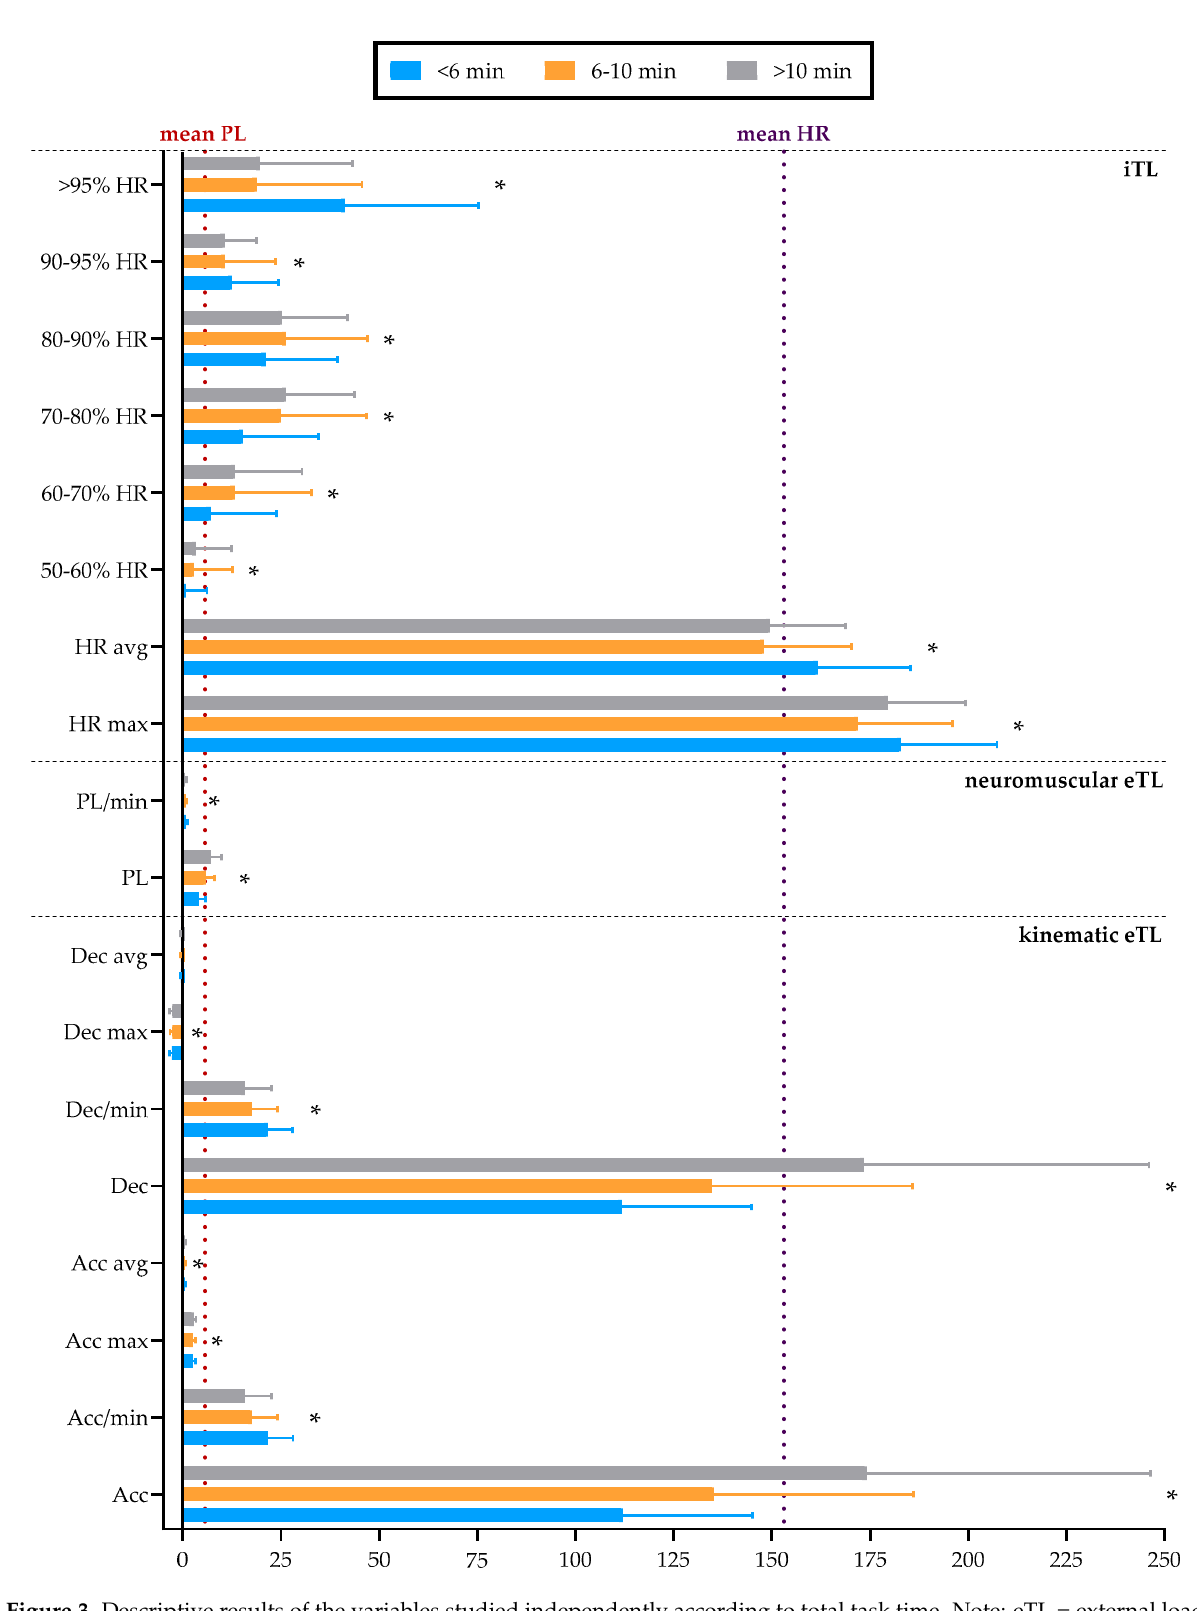
Figure 3. Descriptive results of the variables studied independently according to total task time. Note: eTL = external load; Acc = acceleration; Dec = deceleration; PL = Player Load; iTL = internal load; HR = Heart Rate; min = minute; max = maximum; avg = average. * p < 0.05.